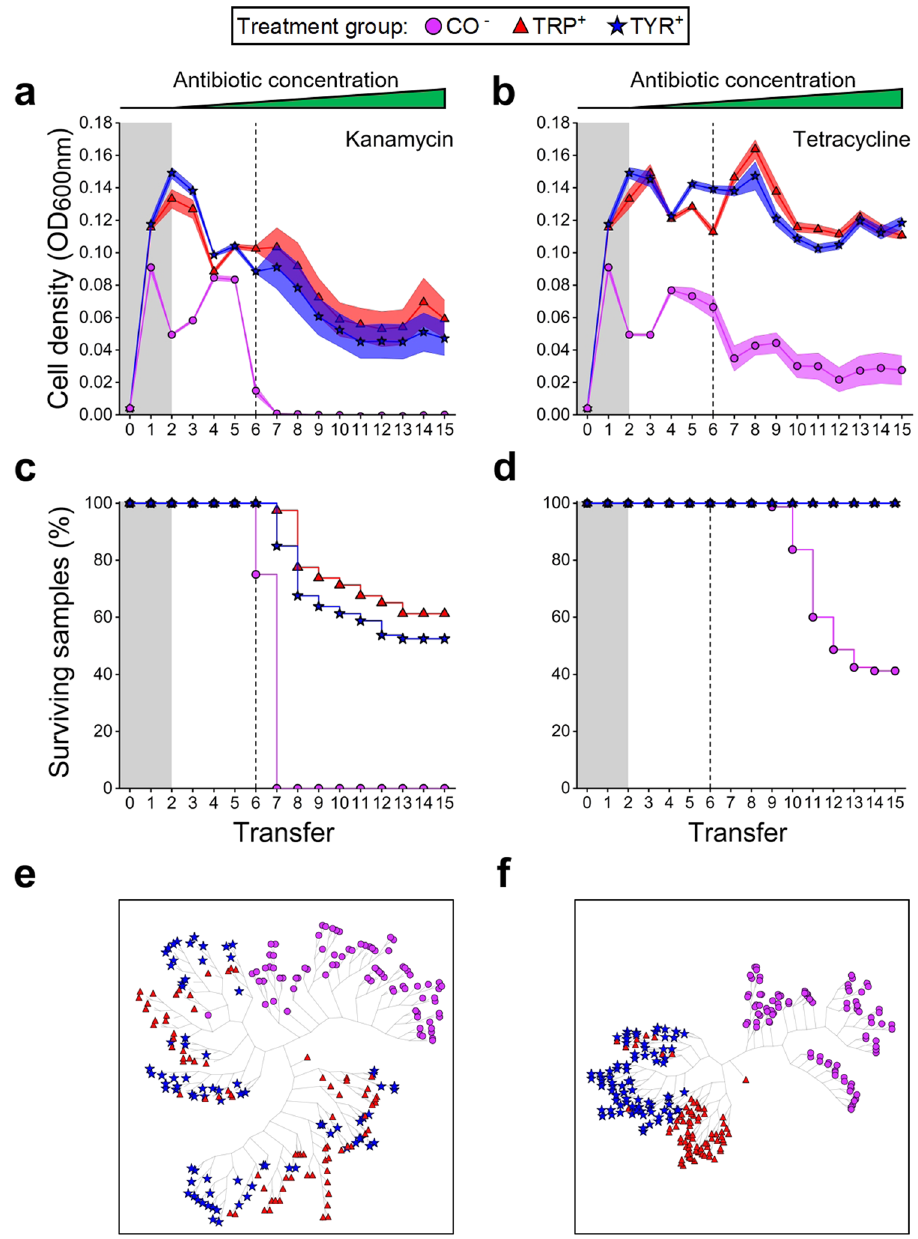
Fig. 2 Mutualistic cooperation limits the ability of strains to adapt to environmental stress. a , b Mean growth (±95% con fi dence interval, n = 80 per point) quanti fi ed as OD 600nm and c , d proportion of surviving replicates in percent ( n = 80 per strain) of auxotrophic monocultures (TRP, TYR) and mutualistic cocultures (CO, purple circles) of the tryptophan (TRP, red triangles) and tyrosine (TYR, blue star) auxotrophic strains throughout the evolution experiment. Antibiotic concentrations were increased in a stepwise manner after each transfer (i.e. every 72 h) (Supplementary Fig. 5). Grey-shaded areas indicate periods without antibiotic treatment. The green triangles above represent the increasing antibiotic concentrations in the evolution experiment ( a – d ). a , c , e kanamycin treatment, b , d , f tetracycline treatment. Dashed lines mark the point when antibiotic concentrations exceeded sub-MIC values. Monocultures were supplemented ( + ) with both amino acids (100 µ M each), while cocultured bacteria depended on the amino acids provided by their respective cross-feeding partner ( − ). e , f Clustering trees of cell density pro fi les of experimental cultures across transfers indicate differences in the evolutionary trajectories taken by the different populations. Each leaf within a given tree represents a replicate ( n = 80 per strain). A radial embedding layout was used to display trees. For exact P -values, see Supplementary Table 3. Source data are provided as a Source Data fi